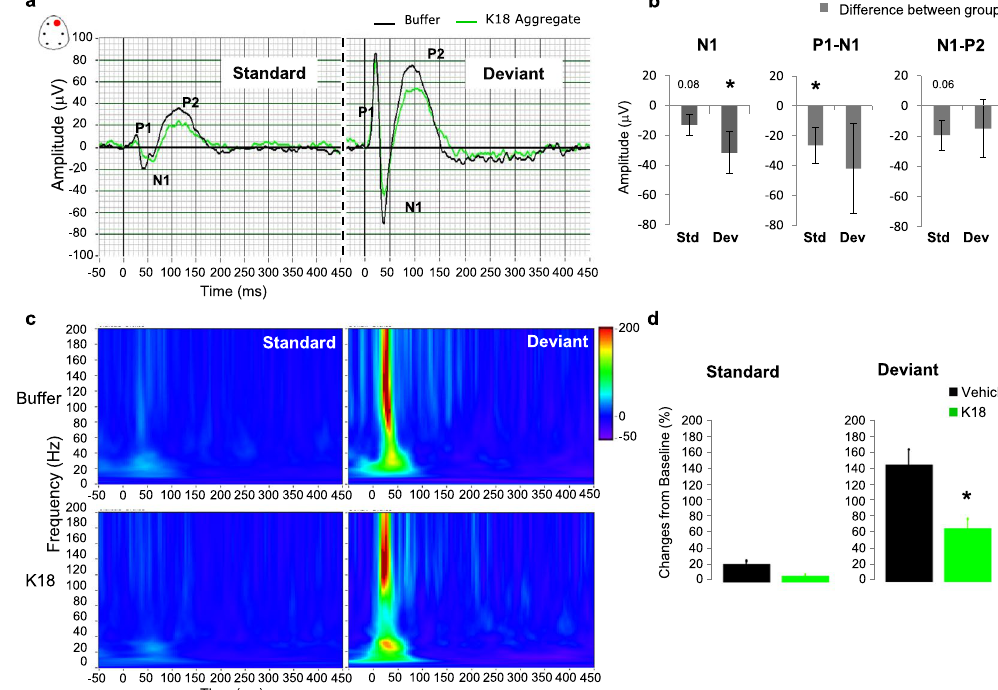
features during information processing. Data are presented as mean values ± SEM for buffer (black, n = 9) and K18 (green, n = 8) groups, 3 animals across different conditions were discarded from the analysis. Mixed effect model